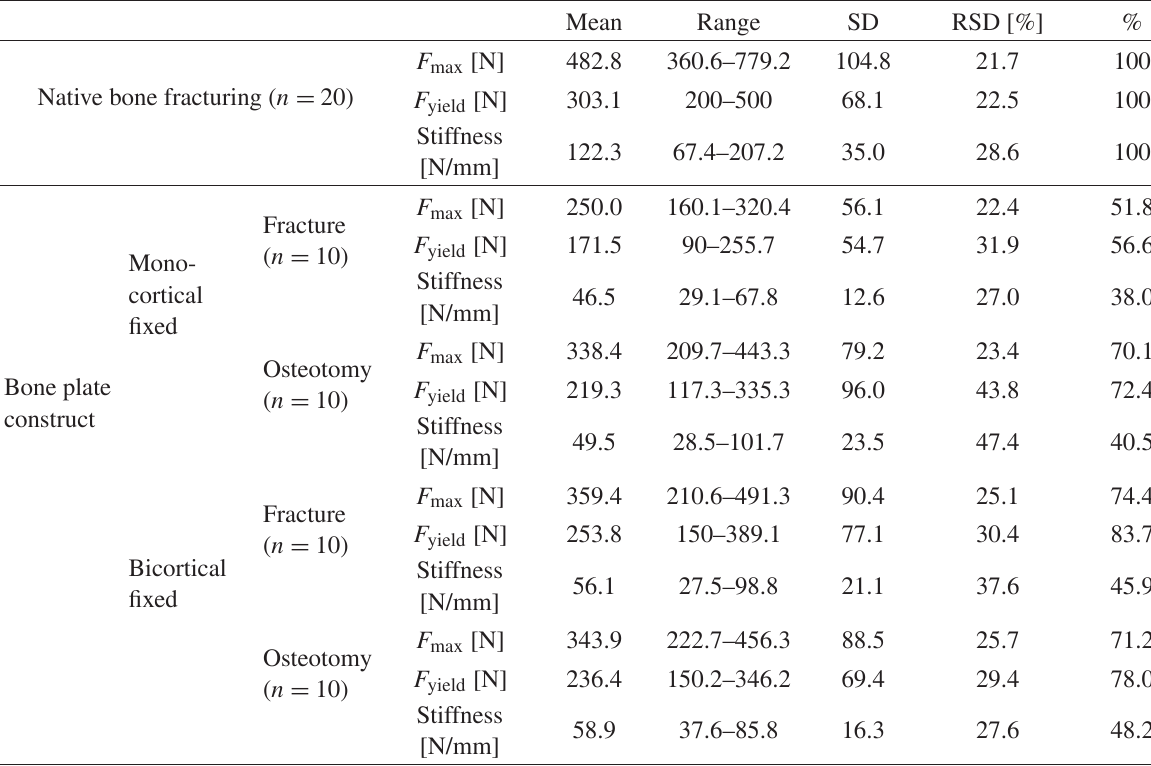
TABLE 1: Maximum load ( F max ), Yield-load ( F yield ), and stiffness of native bones, monocortical- and bicortical-fixed bones in the osteotomy and fracture